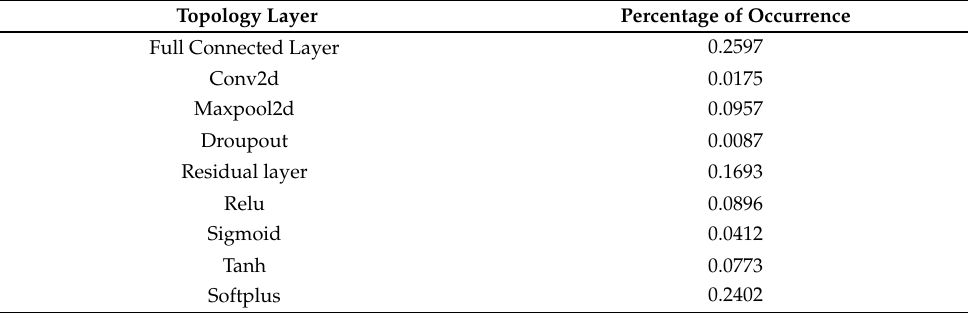
Table 15. Percentage of layer occurrences.